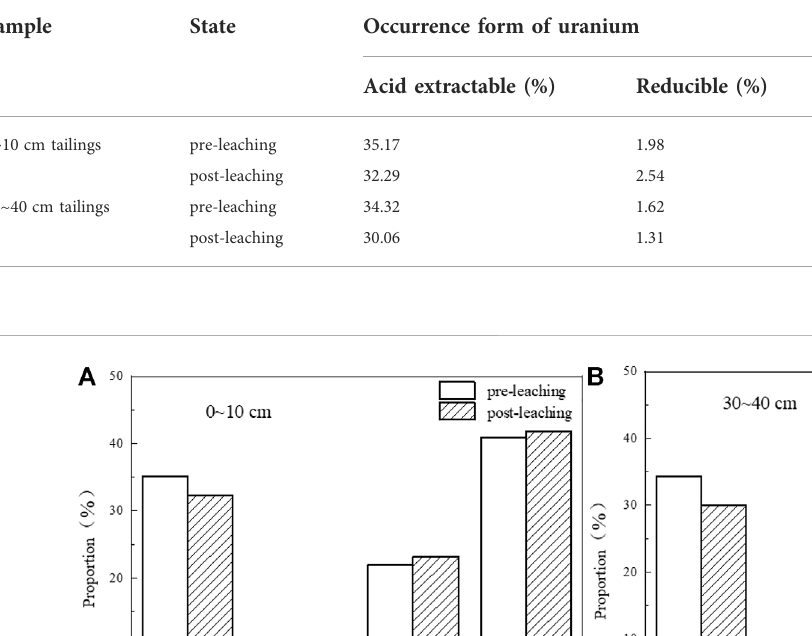
TABLE 5 Percentage of various forms of uranium in tailings during leaching experiment.